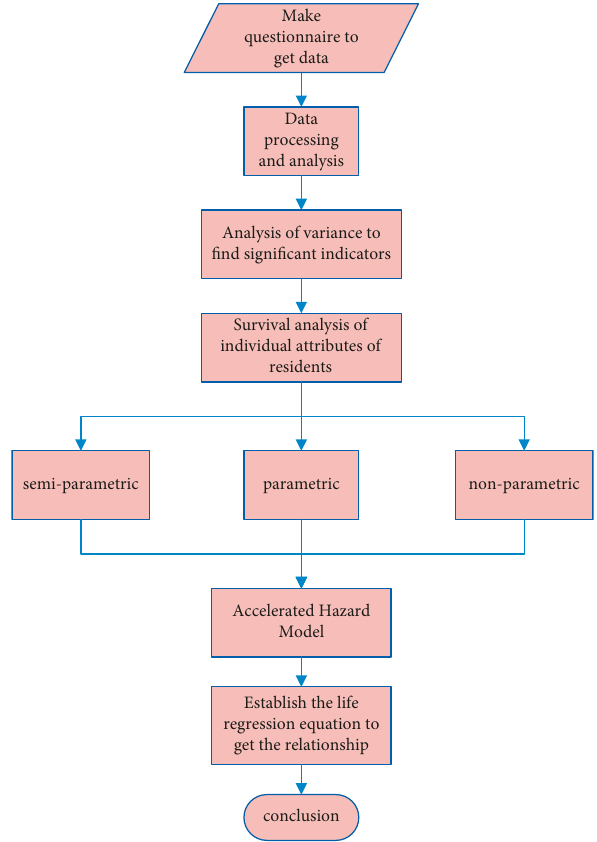
Figure 1: Article structure